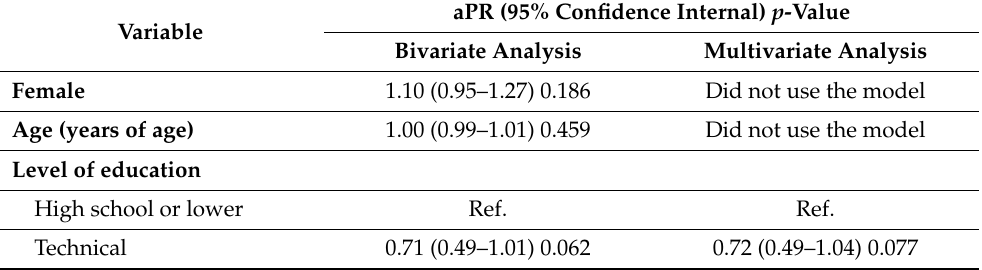
Table 3. Bivariate and multivariate analysis of sociodemographic characteristics and the intent to get vaccinated against COVID-19 in